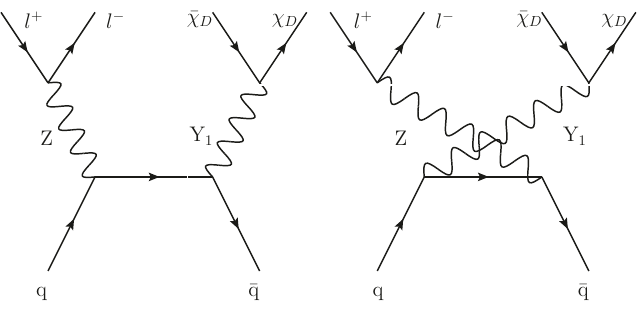
Figure 8 . Representative Feynman diagrams of the dark sector with a spin-1